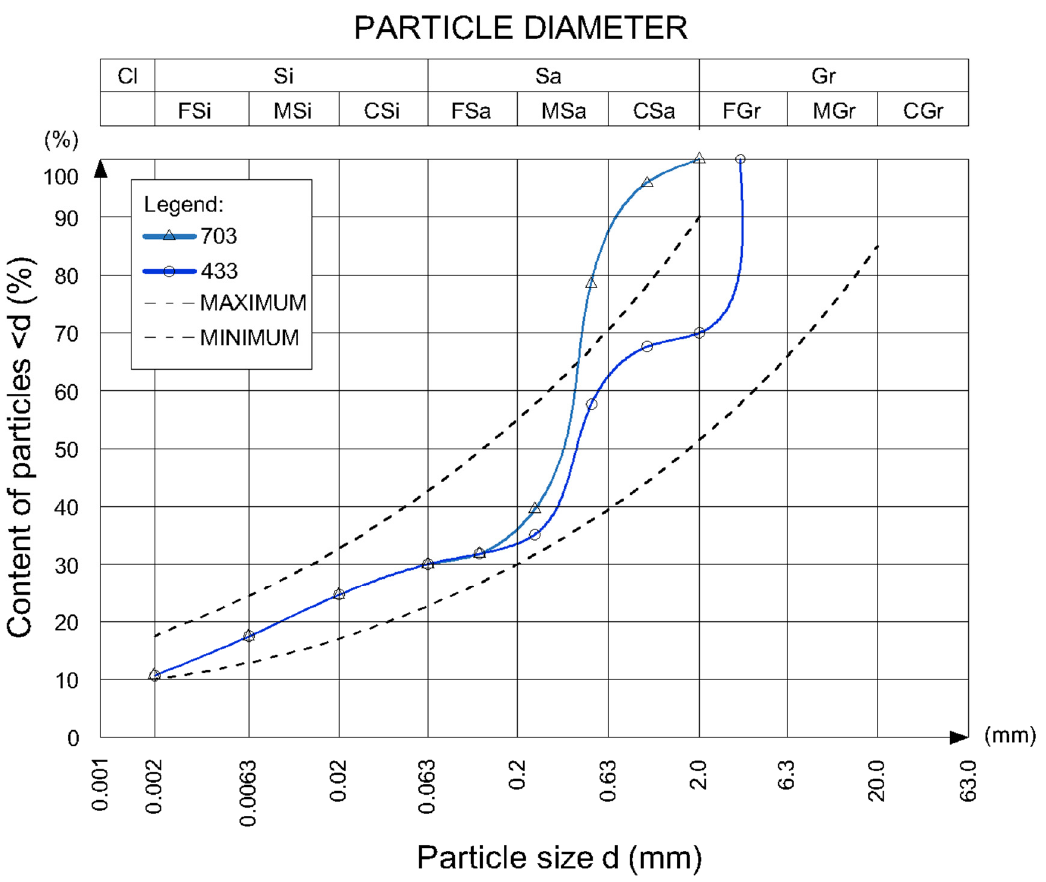
Figure 2. Graining curves of soil mixtures (703 and 433) used for laboratory tests. (Minimum and maximum—recommended grain size area acc. to Houben and Guillaud [42]).